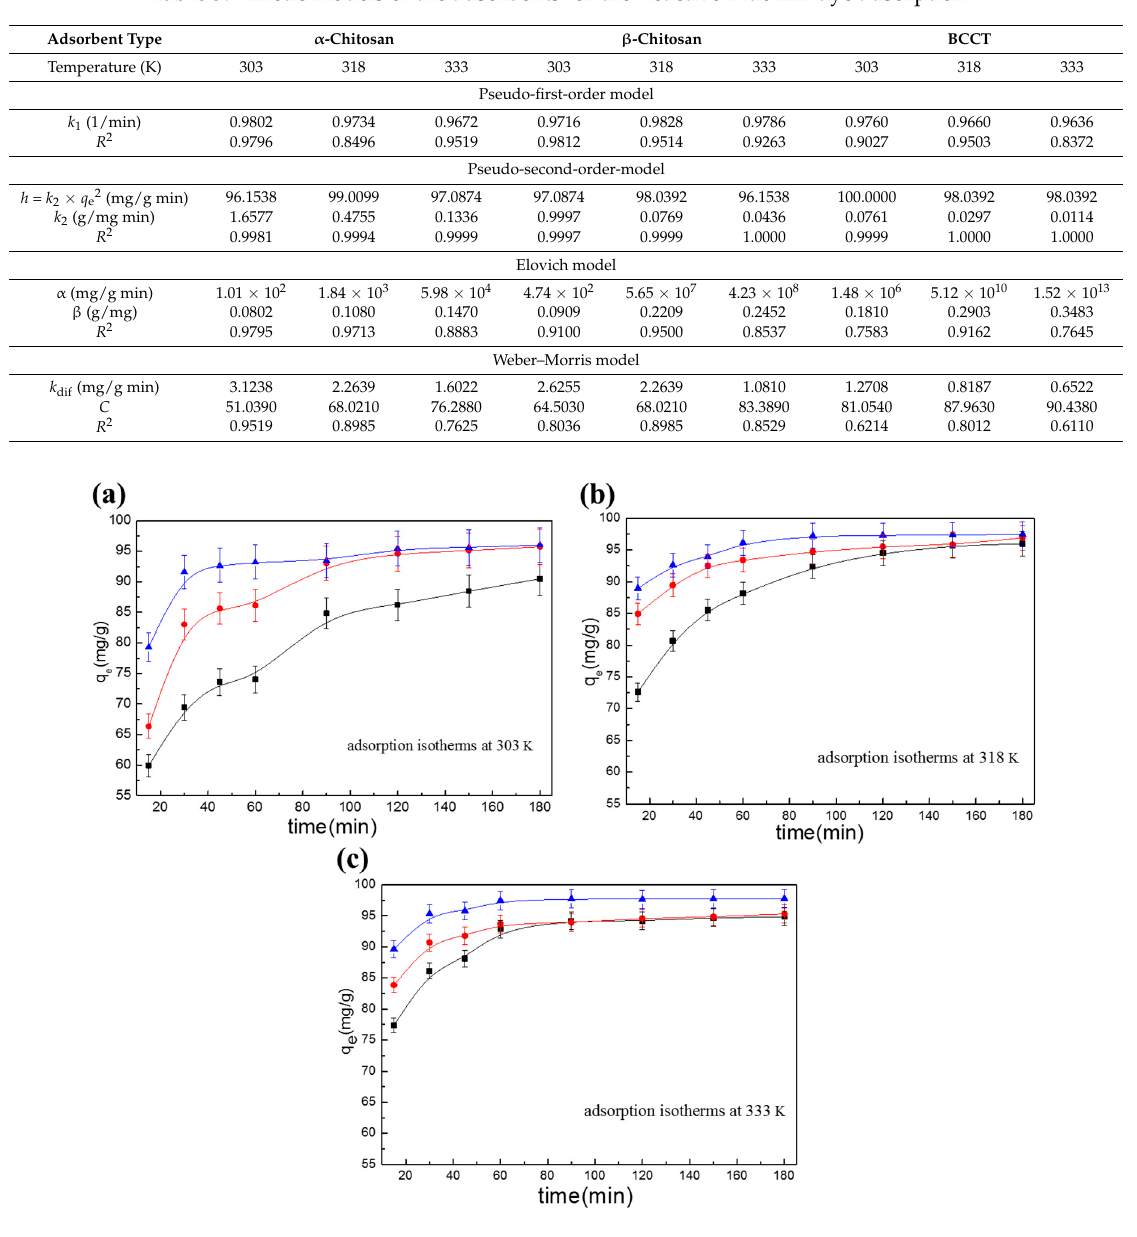
Figure 7. Variations in the adsorption time and adsorption capacity of the adsorbents at different temperatures: ( a ) 303 K; ( b ) 318 K; and ( c ) 333 K ( ■ α -chitosan, ● β -chitosan, and ▲ BCCT). Table 4. Summary of the application of various chitosan-related nanohybrids in the dye effluent treatment.